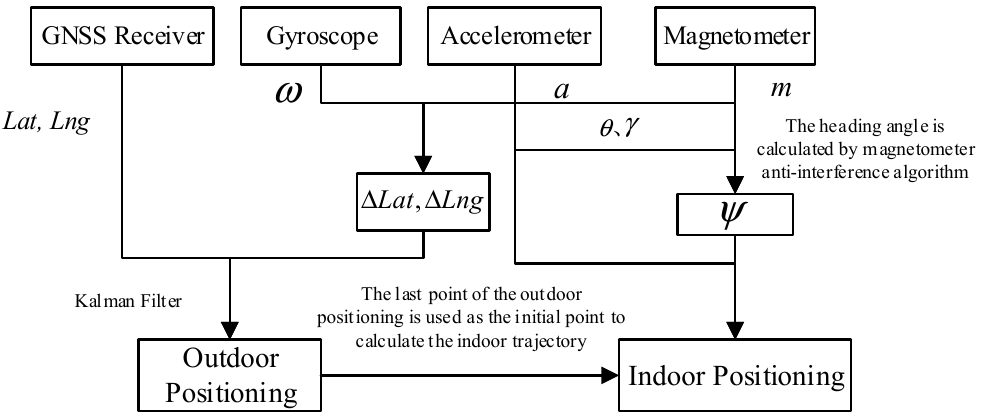
Figure 1. positioning solution of the mobile positioning platform. Figure 1. Positioning solution of the mobile positioning